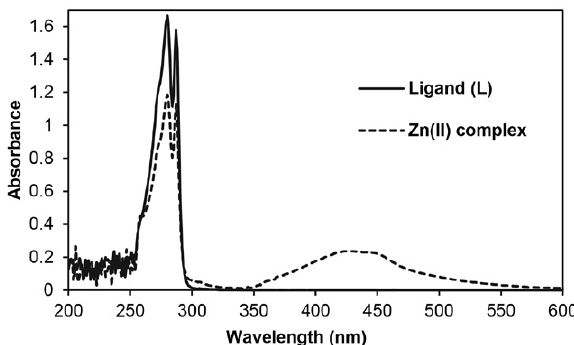
Figure 2. Electronic absorption spectra of ligand (L) and Zn(II)